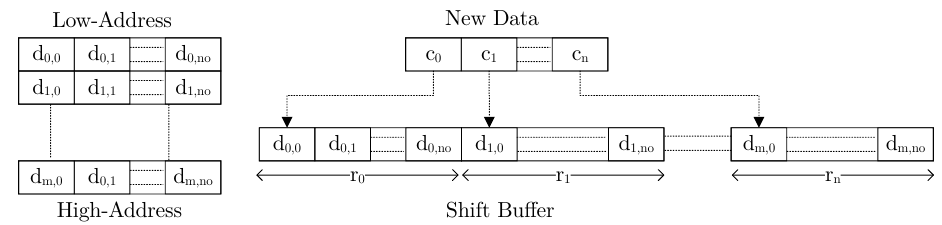
Figure 16. Circular shift-buffer for the